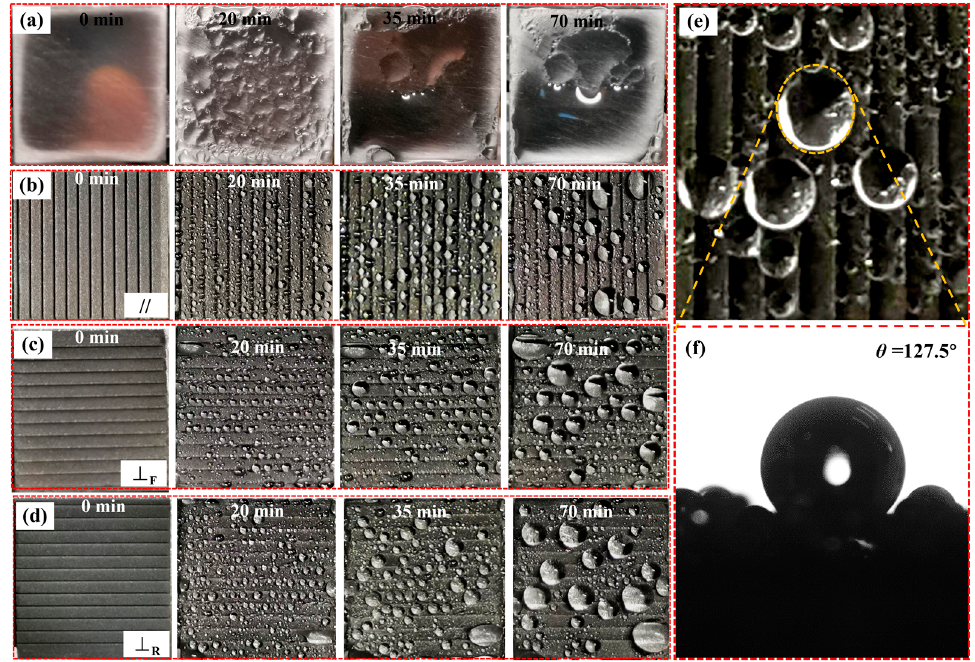
Figure 12. The condensation process of water droplets on different surfaces: ( a ) Smooth titanium alloy surface; ( b – d ) Superhydrophobic titanium alloy surface ∥ , ⊥ F and ⊥ R direction; ( e ) Condensed water droplets state on the superhydrophobic titanium alloy surface, ( f ) Condensed water droplet contact angle.